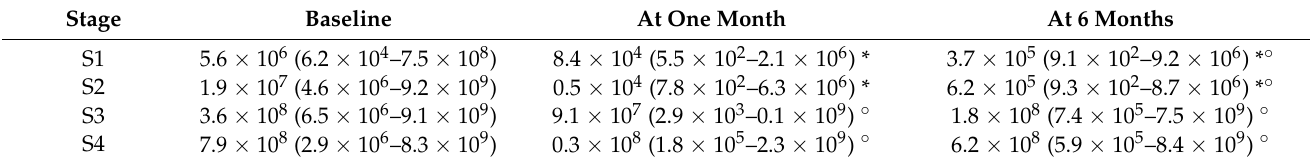
Table 5. Total bacterial load at baseline and at after treatment (one month and six months) in CHX group.